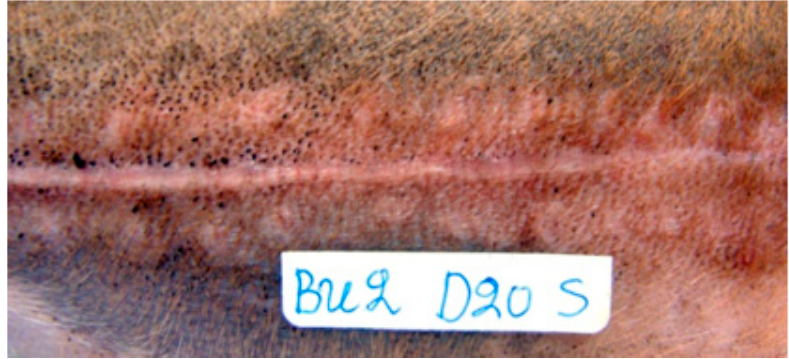
Figure 8. Cross scar formation at wound area closed with staples 20 days